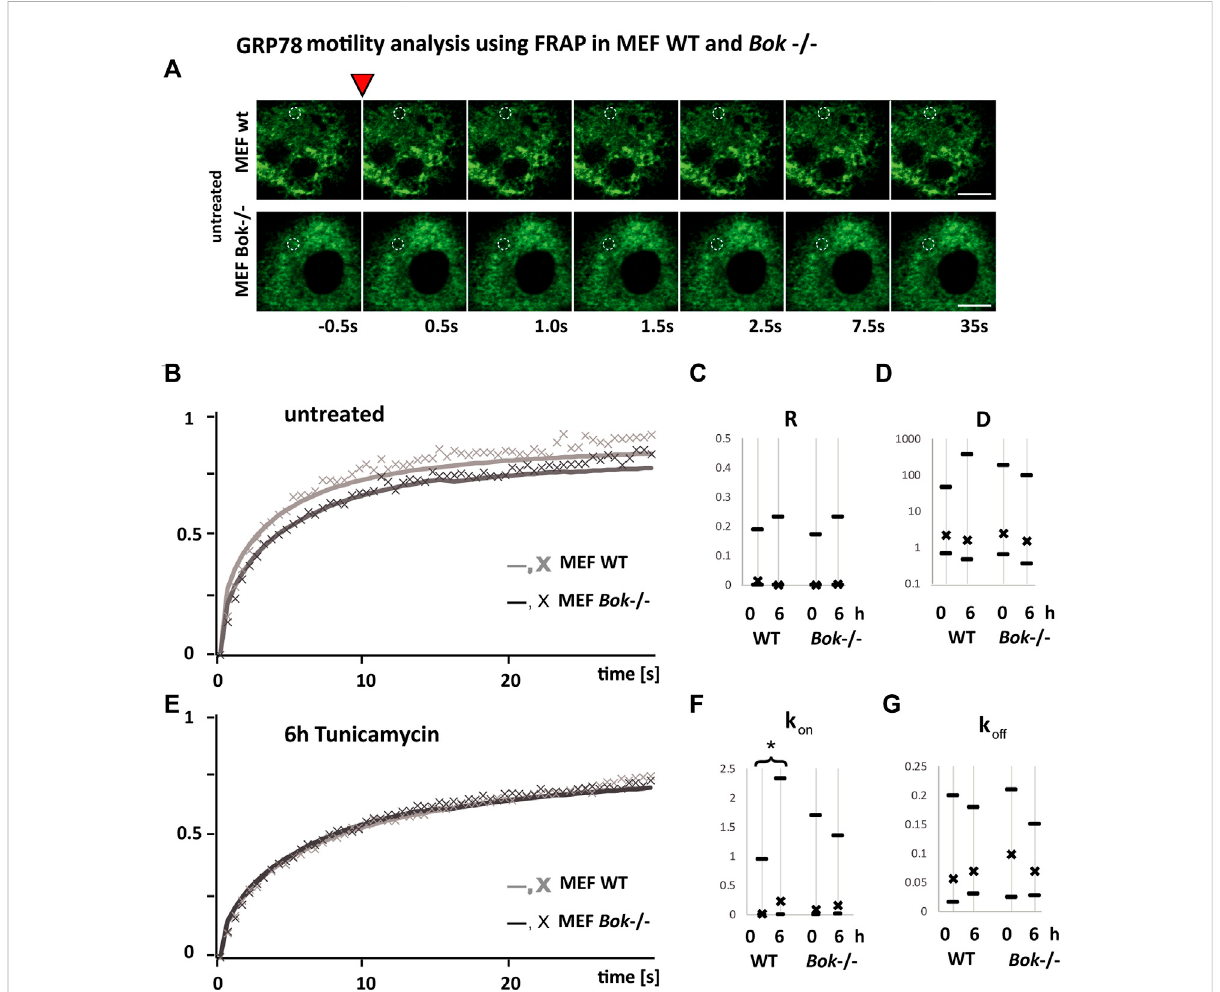
FIGURE 5 GRP78 mobility is reduced in MEF Bok − / − cells. FRAP recovery kinetics of a 1.7 μ m bleached spot in the ER area of MEF WT (light gray line and symbol) compared with MEF Bok − / − (dark gray line and symbol) cells transfected with BiP-eGFP. (A) Examples from FRAP imaging sequences comparing MEF WT and MEF Bok − / − BiP-eGFP-expressing cells. The inverted red triangle indicates the photobleaching step, times of imaging after the bleach step are indicated below, and the bleached area is labeled with a dashed white circle (scale bar = 10 μ m). (B,E) Lines represent the mean of all fi tted curves, and the X symbol represents the mean of the measured kinetics normalized to the maximum difference of baseline and bleached and corrected for bleaching during measurements. The curves show kinetics before (B) and after 6 h (E) of treatment with 3 μ M tunicamycin. Comparison of the recovery kinetics median and the 25 and 75% quartiles using the four fi tting parameters, the immobile fraction (R), the diffusion (D) , the binding (k on ), and the dissociation (k off ) of BiP-eGFP (C,D,F,G) . The binding (k on ) is signi fi cantly increased after 6 h in WT but not in Bok − / − . A minimum of 94 FRAP curves from three independent experiments were analyzed per group (WT, untreated n = 112; WT, 6 h Tm n = 94; Bok − / − , untreated n = 98; Bok − / − , 6 h Tm n = 99); * indicates a signi fi cant difference using the Kruskal – Wallis and Dunn ’ s test; # indicates two-tailed t-test, non-homogenous variances, p =